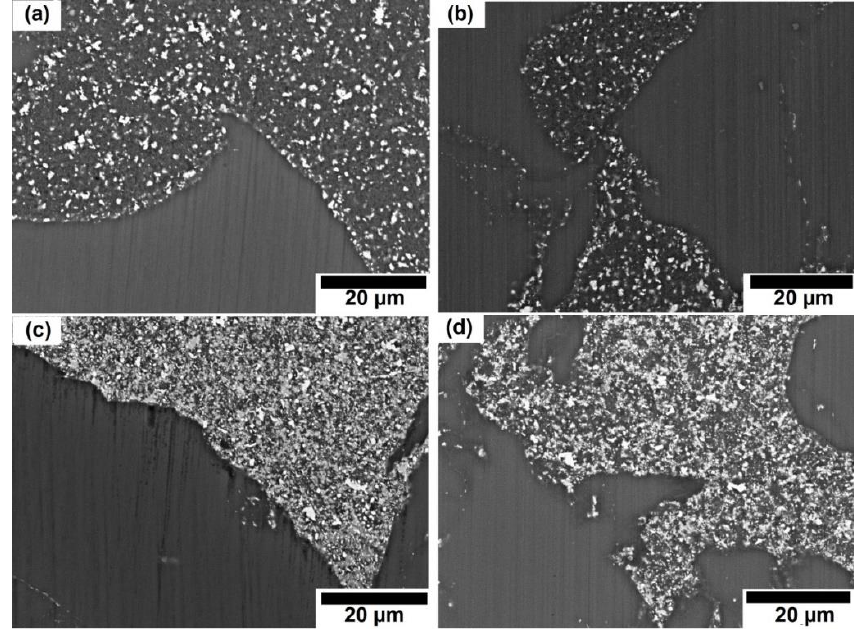
Figure 2. SEM (scattering electron microscope) images of ( a ) sample B-1; ( b ) sample B-2; ( c ) sample C-1; and ( d ) sample C-2.